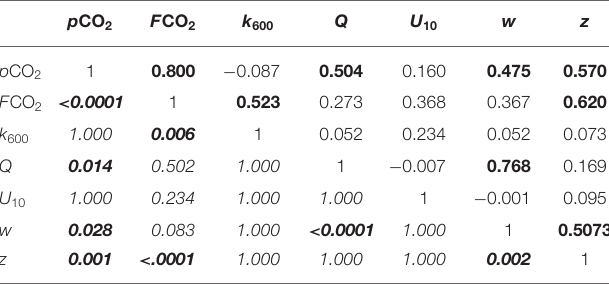
TABLE 2 | Spearman correlation matrix showing the r -values in the top right side of the diagonal and adjusted p -values in the bottom left side in italic. p CO 2 F CO 2